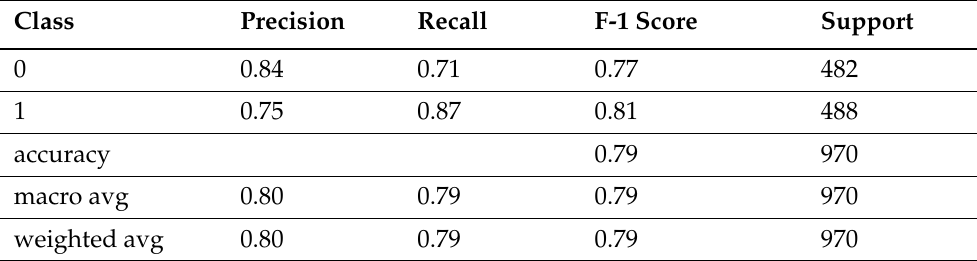
Table 9. Classification report for TF-IDF with Naive Bayes.